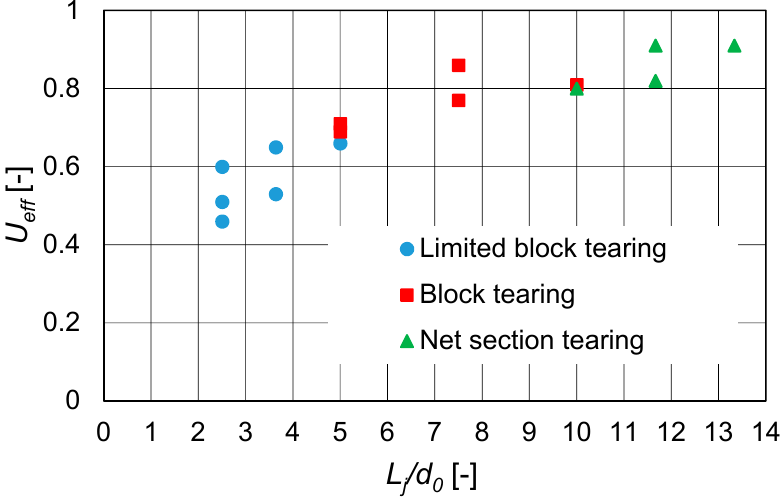
Figure 16. Effective stress distribution in net cross section A net (line A–D) for elements with various failure modes: ( a ) specimen J6/2/45/25 (limited block tearing); ( b ) specimen J8/2/110/40 (block tearing); ( c ) specimen J6/4/70/34 (net section tearing).